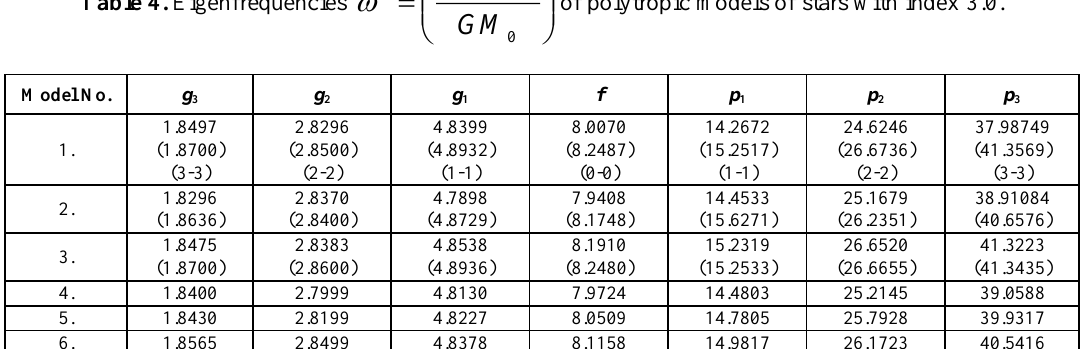
Table 4. Eigenfrequencies of polytropic models of stars with index